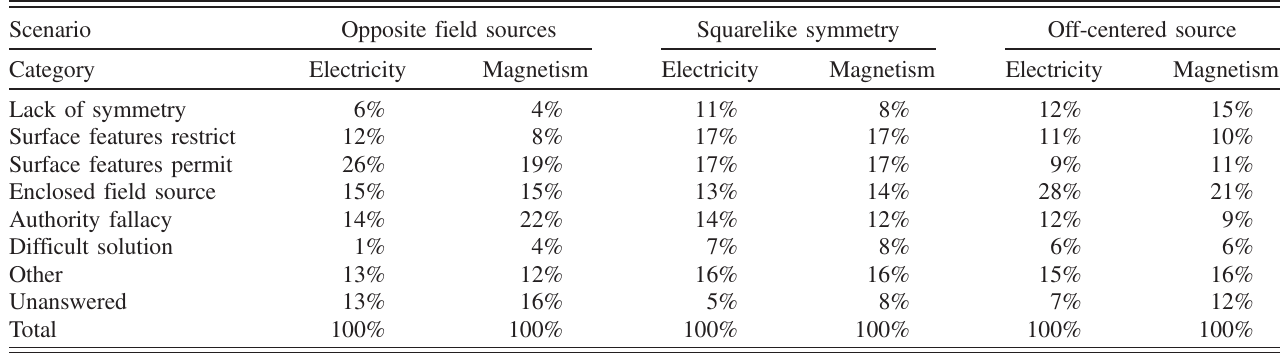
TABLE VIII. Percentages for each descriptive category by scenario and